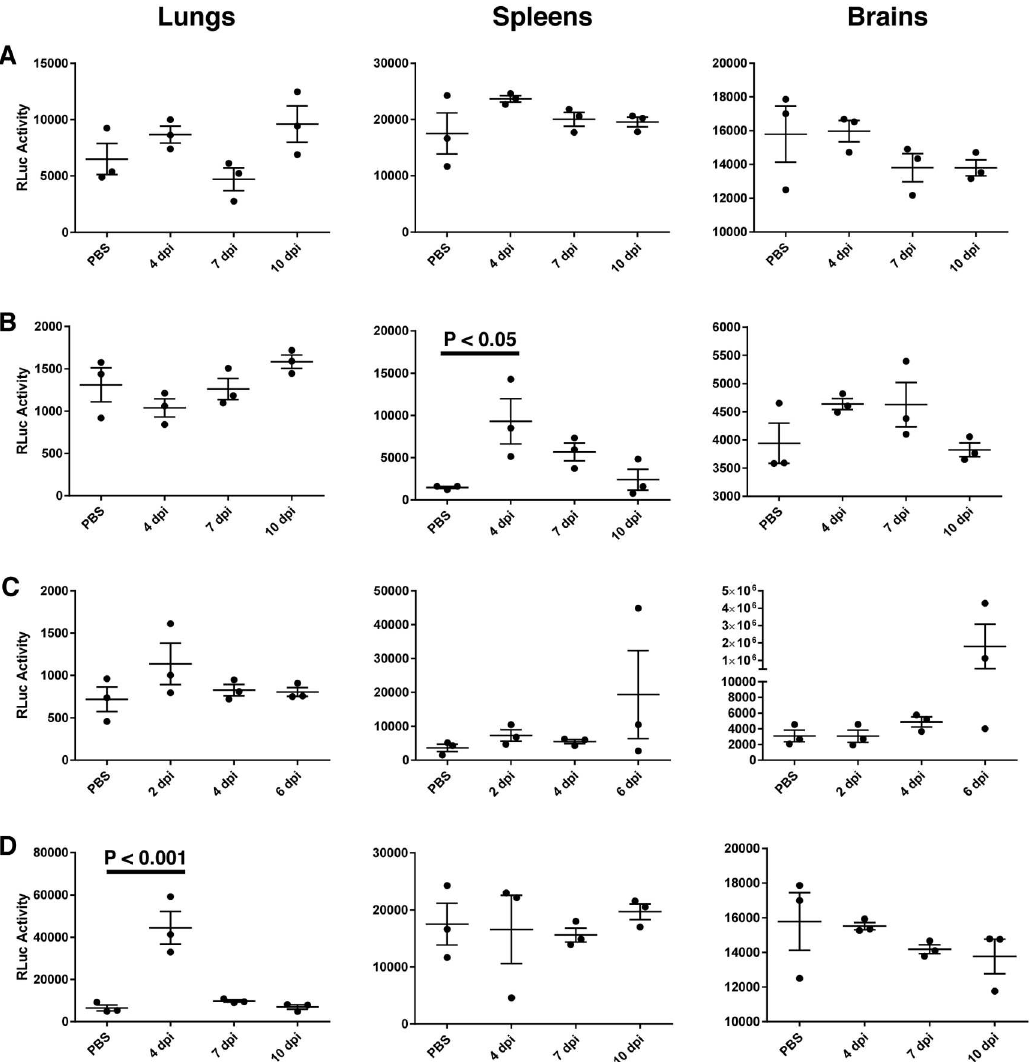
Fig 1. Susceptibility of IFN- α / β R − / − mice to rMuV-RLuc by various inoculation routes. IFN- α / β R − / − mice were infected with (A) 6x10 6 PFU rMuV-RLuc in 200 μ Ls.c., (B) 6x10 6 PFU in 200 μ Li.p., (C) 1000 PFU in 20 μ Li.c., (D) 3x10 6 PFU in 100 μ Li.n., or mock infected with PBS in the respectivevolume for each route. Lungs, spleens,and brains were harvested from mice 4, 7, and 10 dpi (s.c., i.p., and i.n. routes) or 2, 4, and 6 dpi (i.c. route). Tissues were homogenized and renilla luciferase activity was measuredas describedin materials and methods. ANOVA and Tukey multiple comparisontests were used to calculate P